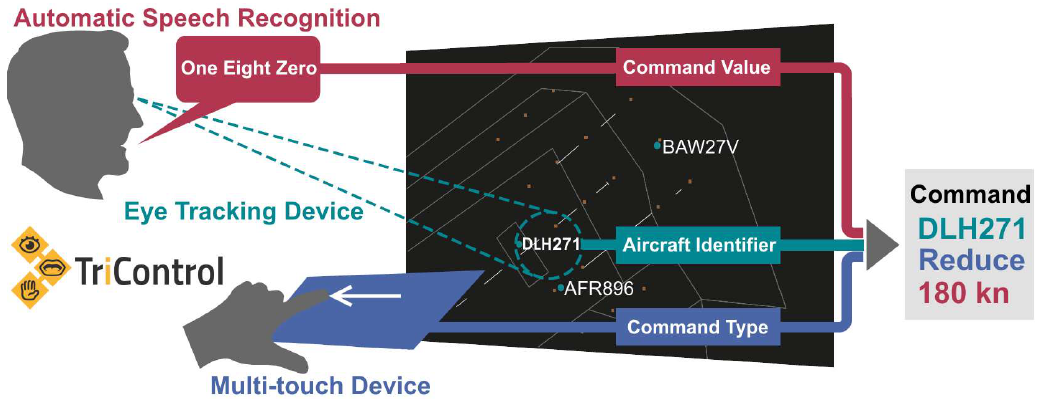
Figure 3. Interaction concept of TriControl with fusion of three modalities adapted from [34].